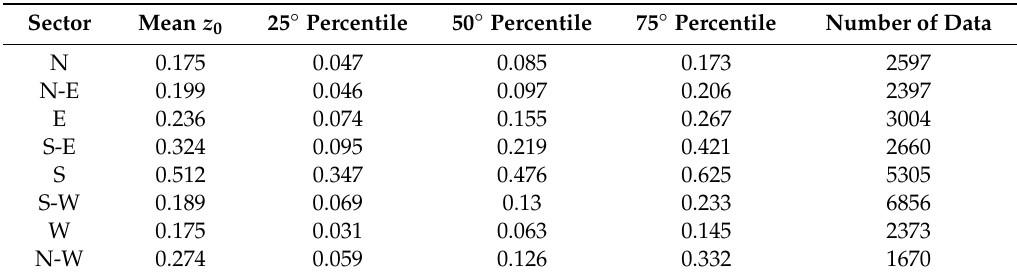
Table 8. Surface roughness z 0 for TVGr.